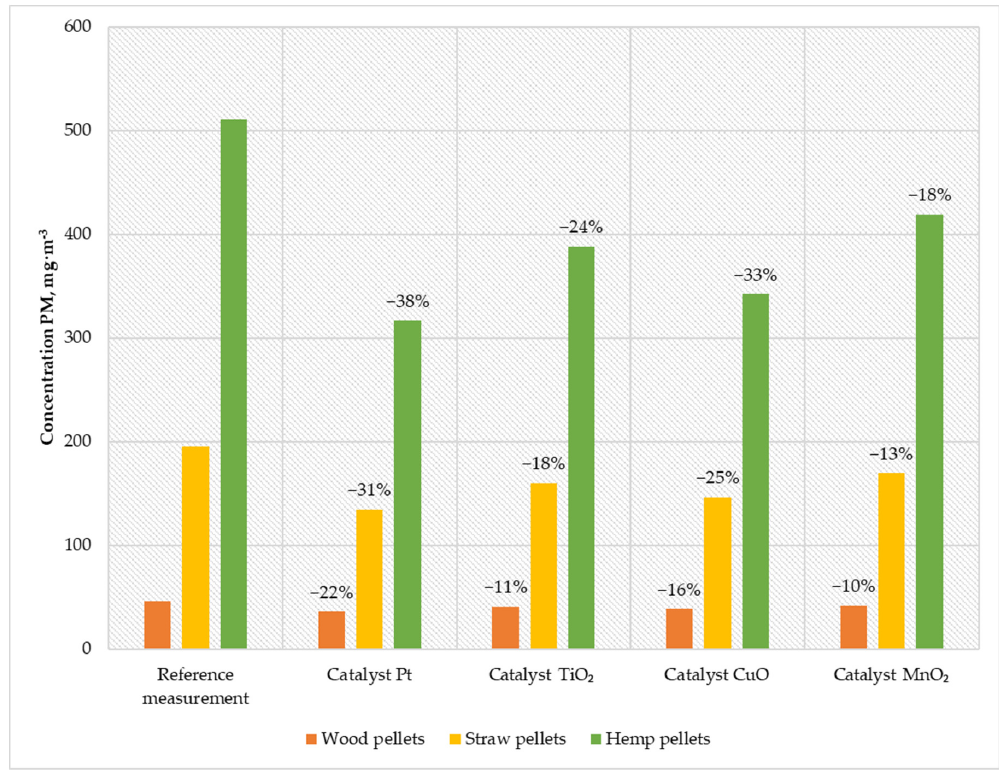
Catalysts 2022 , 12 , 710 Figure 7. Average PM content in the flue gas from a low-power biomass boiler. Figure 7. Average PM content in the flue gas from a low-power biomass boiler. When feeding the boiler with wood pellets, the emission was 36 mg·m − 3 ,;when burn- ing straw pellets, the emission was 134 mg·m − 3 ; and when using hemp pellets, the emis- sion was 316 mg·m − 3 . Using the CuO catalyst, the emission was reduced to 38 mg·m − 3 for wood pellets (meeting the requirements of the Ecodesign directive), 146 mg·m − 3 for straw pellets, and 342 mg·m − 3 for hemp pellets. Using a titanium catalyst caused PM emission at a level of approx. 40 mg·m − 3 for wood pellets; while burning straw pellets, the emission was 159 mg·m − 3 ; and when feeding the boiler with hemp pellets, the emission was 388 mg·m − 3 . The least effective solution was the MnO 2 catalyst, reducing suspended dust emis- sions by 10% for wood pellets, 13% for straw pellets, and 18% for hemp pellets.